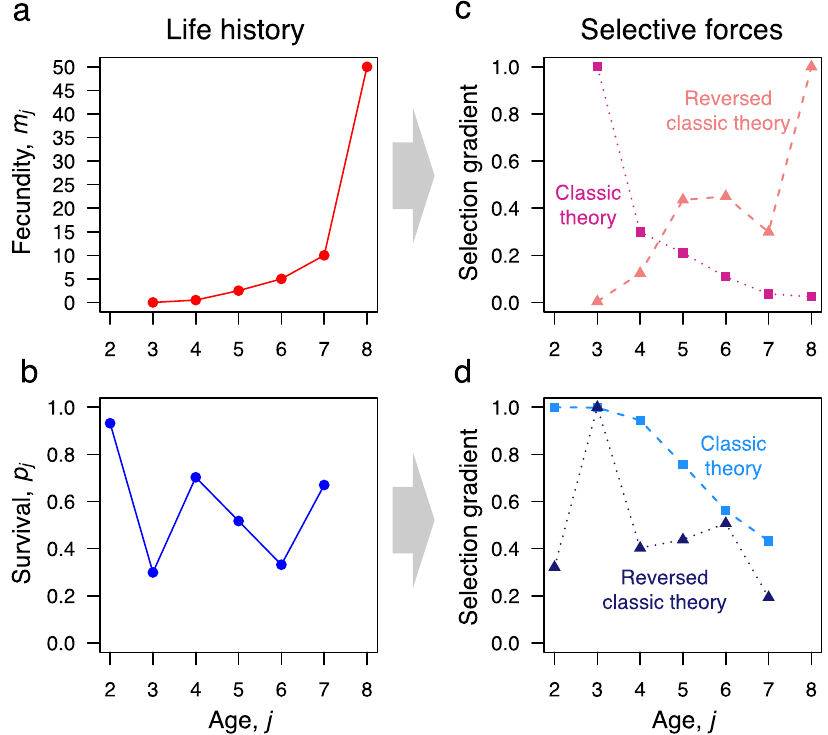
Fig. 1 Selection gradients on fecundity and survival under additive and proportional effects. a , b Fecundity m j at age j and survival p j from age j to j + 1 are reported for a hypothetical life history with fi rst reproduction at age 3 and maximum age 8. Survival at prereproductive ages is p 0 = 0.408 and p = 0.943. c , d Selection gradients for this life history are computed on both fecundity and survival under both additive (dotted line) and proportional 1 (dashed line) genetic effects. The classic theory 8 of the evolution of ageing assumes additive effects on fecundity and proportional effects on survival, which lead to selection gradients that decline with reproductive age. These are here compared with the reversed case 13 : proportional effects on fecundity and additive effects on survival, which may lead to selection gradients that do not decline with reproductive age. Selection gradients are scaled relative to their maximum